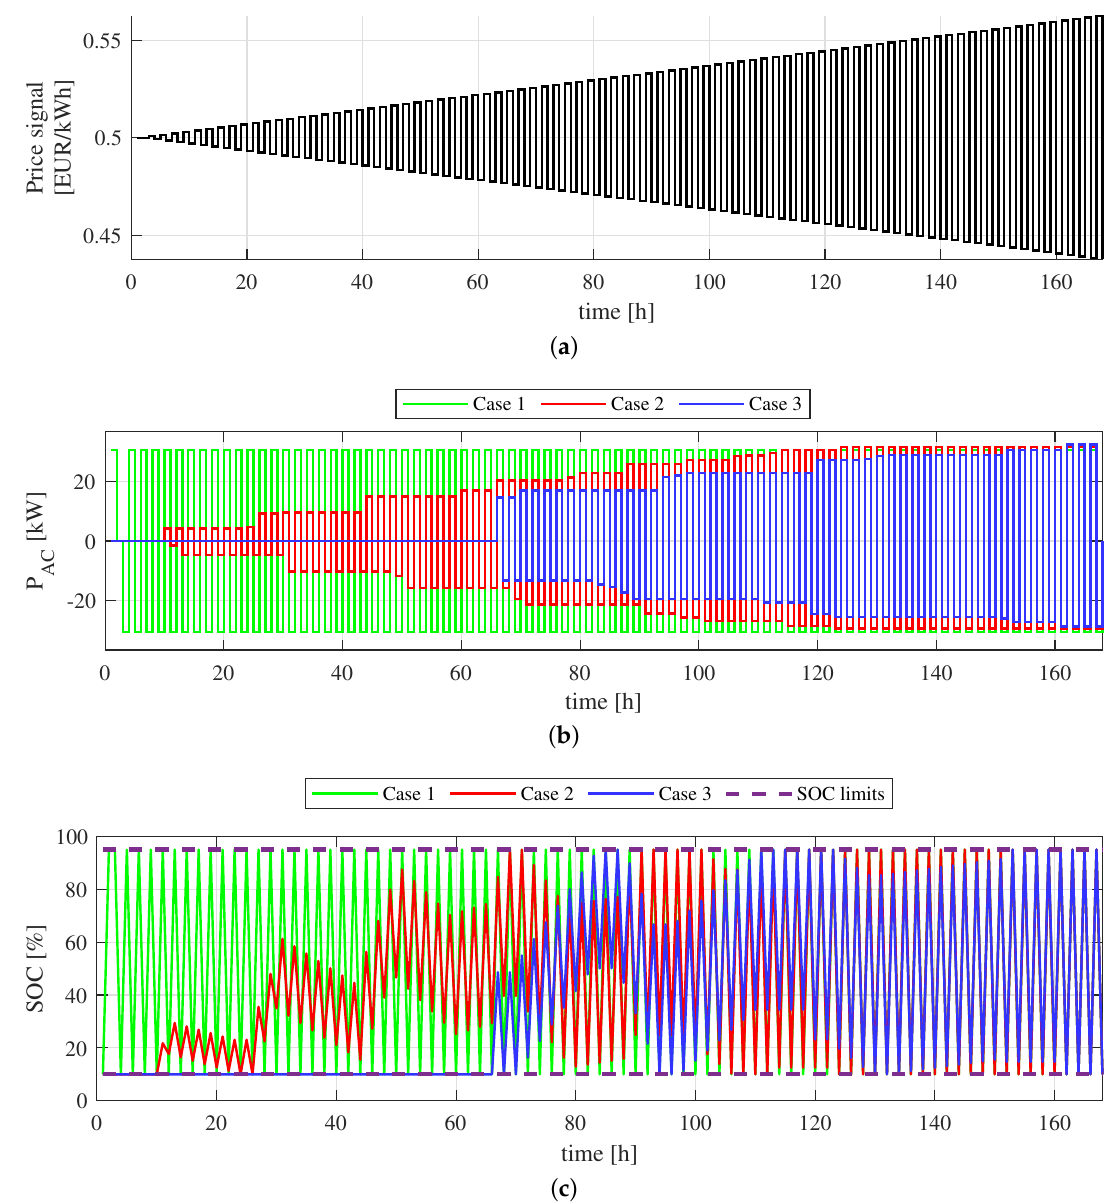
Figure 5. Results of optimising dispatch for the three case study scenarios (Case 1: “All losses neglected”; Case 2: “Battery ageing and battery dissipation losses considered”; and Case 3: “Battery ageing, dissipation losses of both power electronics and battery considered”. Subfigures indicate ( a ) Price signal; ( b ) AC power dispatch; and ( c ) state of